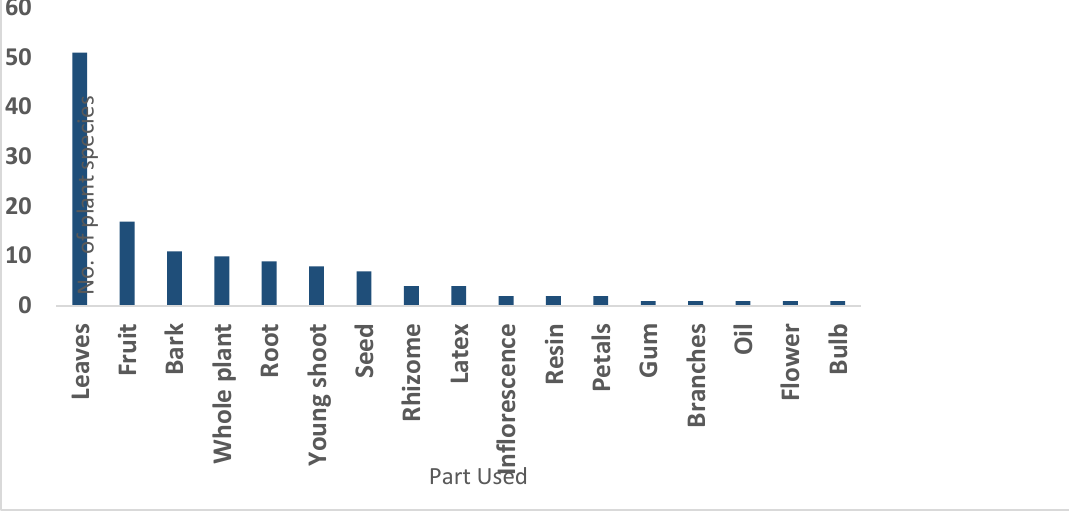
Figure 2. Plant parts used in the preparation of remedies.